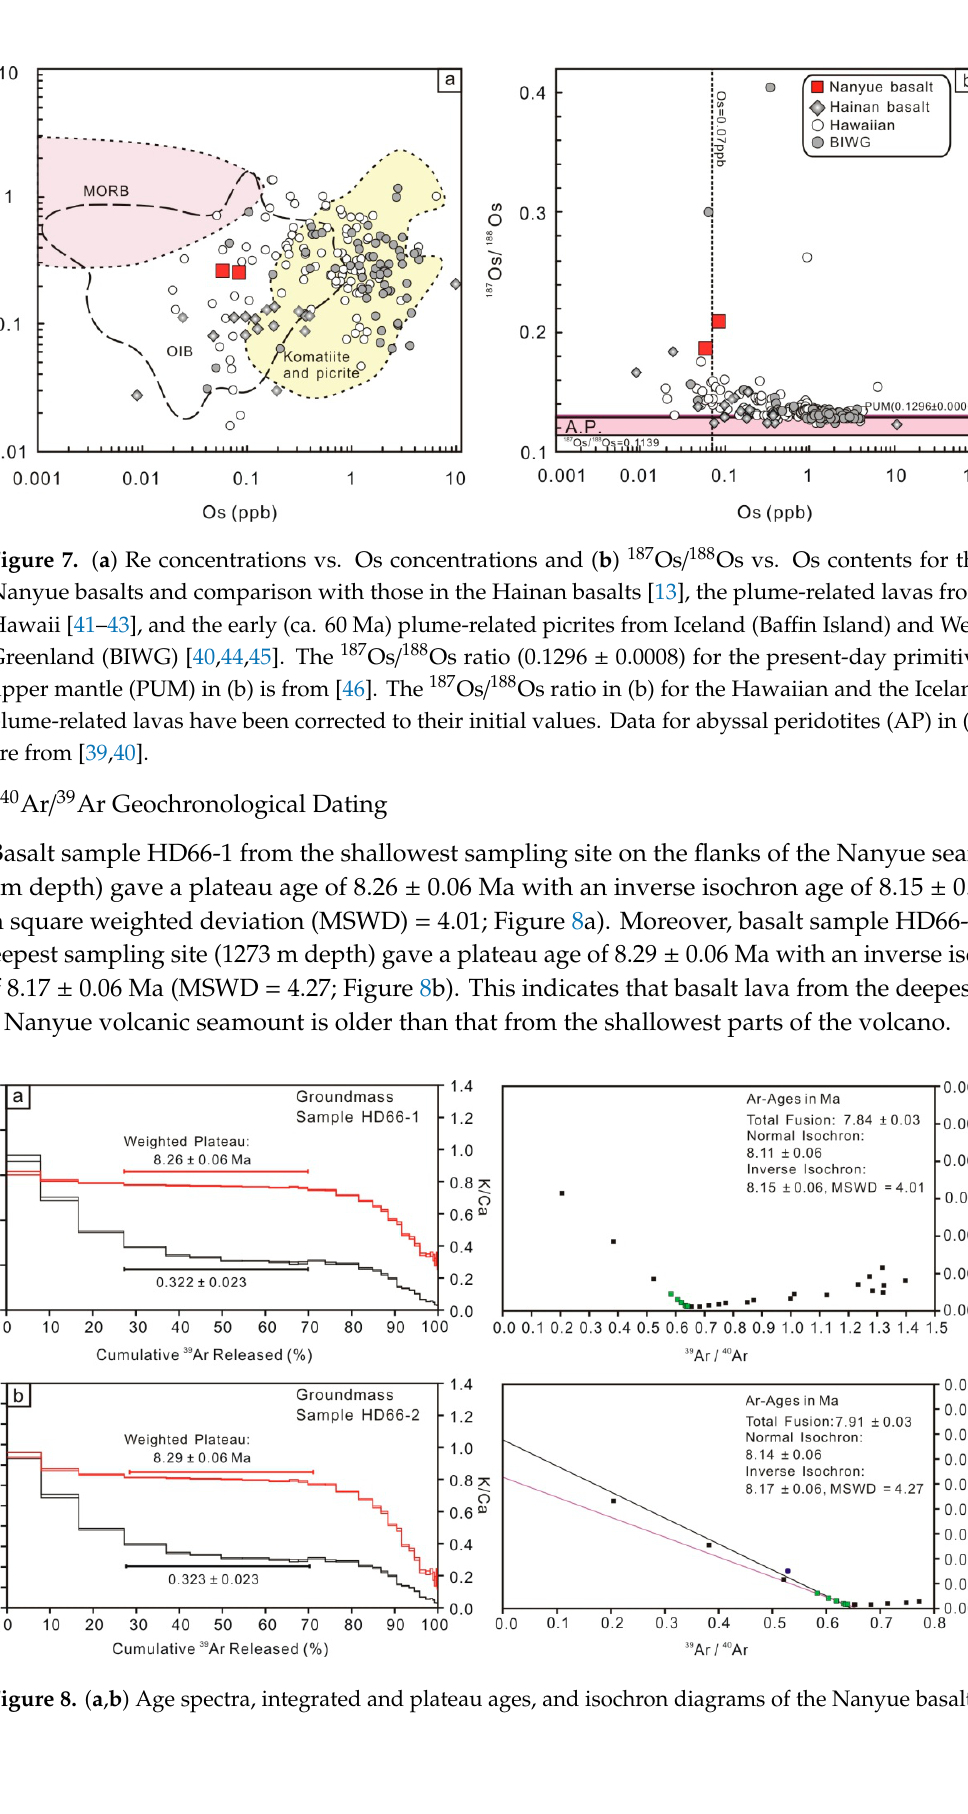
11 of 19 Figure 6. Isotopic plots of: ( a ) 208 Pb/ 204 Pb vs. 206 Pb/ 204 Pb and ( b ) 207 Pb/ 204 Pb vs. 206 Pb/ 204 Pb for the Nanyue basalts. Sources of data for comparison: the Pacific MORB and the Indian MORB are from [30] and the Hainan OIB is from [11,12,28,31]. The Northern Hemisphere reference line (NHRL) is from [37]. Sources of data used for the end-member mixing calculations: the average isotopic composition of the Hainan OIB is from [11,12,28,31], the average isotopic composition of the Pacific MORB is from [30], and the isotopic composition of the LCC is from [35]. Each white dot on the mixing lines represents various increments of melt fractions from the average Hainan OIB, the average Pacific MORB, and the LCC. Data references of enriched mantle (EM)-I and -II end-members are from [36]. The geochrones in (a) are from Figure 3(a) in [13]. Compositional data of volcanic rocks from the IODP Sites U1433 and U1434 are from [5]. 4.2.3. Re–Os Isotope Systematics The Nanyue basalts had low Os content (60.37–85.13 ppt) and moderate Re concentrations (249.60–255.11 ppt). In the Re vs. Os diagram, the investigated basalts plot in the field of OIB and high-MgO lavas (Figure 7a). In addition, the Nanyue basalts were poorer in Re than most MORB-type rocks [39] but contained more Re than the Cenozoic OIB lavas from the near Hainan Island [13]. They also plot outside of the compositional field of plume-related picrites from Iceland (Baffin Island) and west Greenland (BIWG) [40–45].